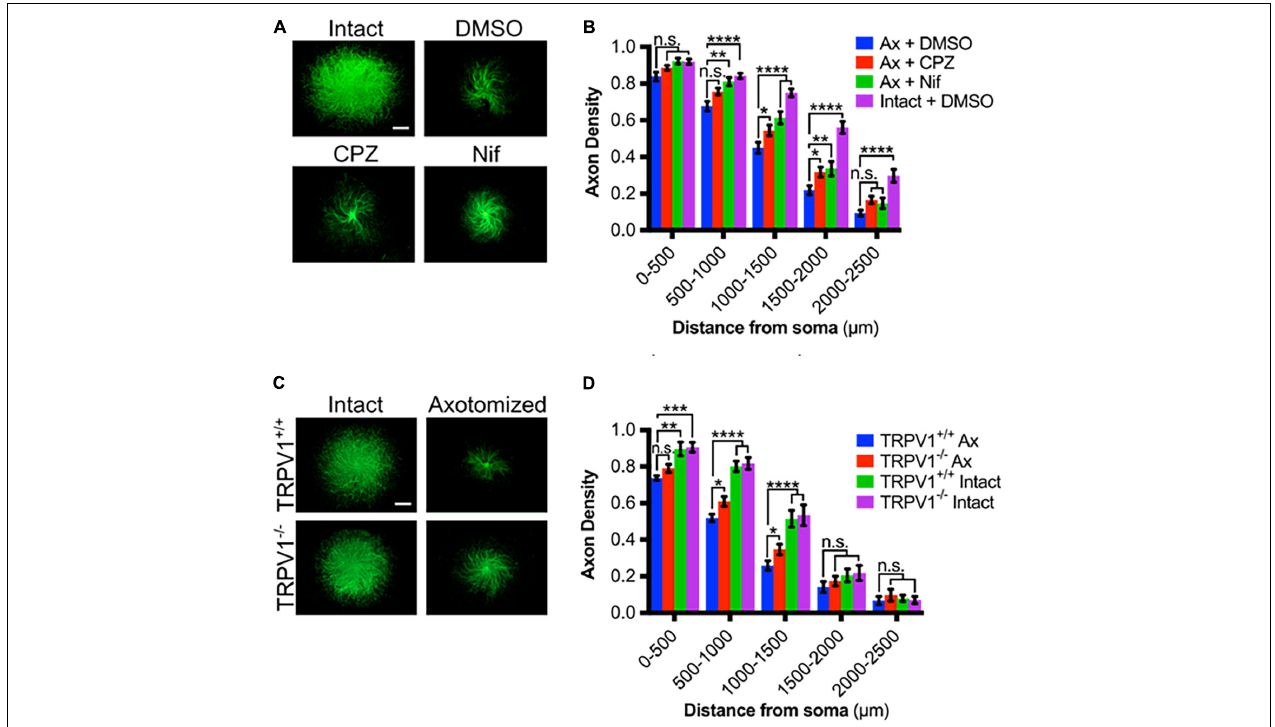
FIGURE 2 | TRPV1 is required for Ca 2 + influx in transected axons. (A) Intact or axotomized DRG axons in the absence or presence of CPZ (10 µ M – 30 min pre-incubation), Nif (10 µ M – 30 min pre-incubation), or DMSO (0.1% v/v – 30 min pre-incubation), immunostained for β -III tubulin (scale bar indicates 1,000 µ m). (B) Axon density of intact or axotomized (Ax) DRGs in radial bins of increasing distance from the center [ n = 17 (Ax + CPZ), n = 16 (Ax + Nif), n = 13 (Ax + DMSO)]. (C) Intact or axotomized trpv1 + / + and trpv1 – / – DRG axons immunostained for β -III tubulin (scale bar indicates 1,000 µ m). (D) Axon density of intact or axotomized (Ax) DRGs in radial bins of increasing distance from the center [ n = 6 ( trpv1 + / + Ax and trpv1 – / – Ax), n = 3 ( trpv1 + / + Intact and trpv1 – / – Intact)]. Values are mean ± SEM. Statistical significance was assessed using a two-factor ANOVA followed by Dunnett’s test relative to trpv1 + / + Ax (D) , * p < 0.05, ** p < 0.01, *** p < 0.001, **** p < 0.0001.